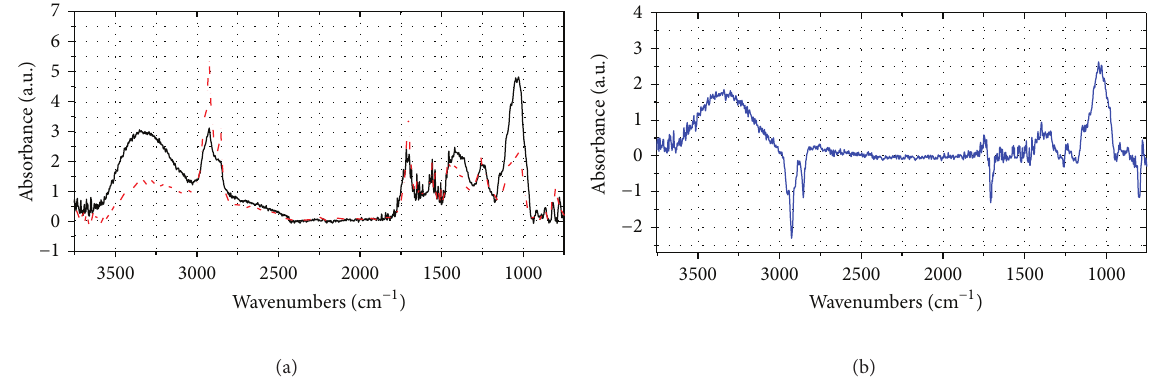
F 2: ATR-FTIR spectra of resonant and nonresonantly irradiated samples. (a) ATR-FTIR spectrum of resonantly irradiated samples (solid black line) versus nonresonantly irradiated samples (dashed red line). (b) Difference between the resonant and nonresonant ATR–FTIR